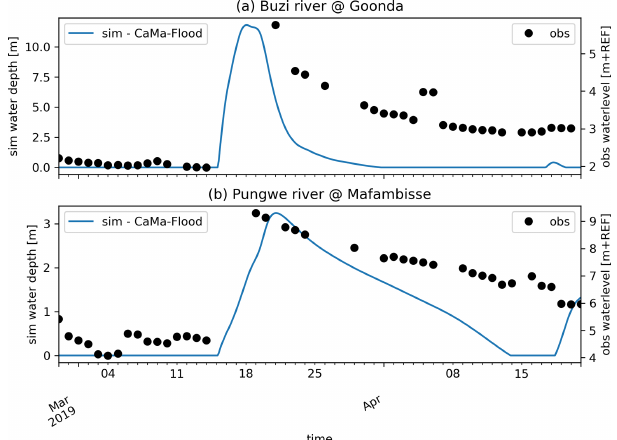
Figure A1. Comparison of observed water levels and simulated water depths during Tropical Cyclone Idai in the Buzi (a) and Pungwe (b) rivers. Note that the comparison is based on approximate locations as the precise locations could not be retrieved. Further- more, as the vertical datum of the observations is unknown, these are plotted on a second y axis.